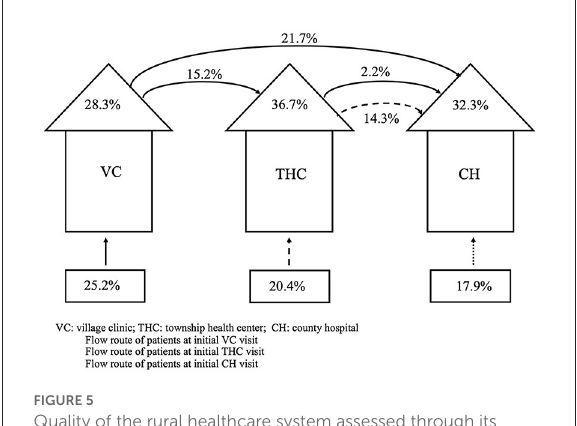
FIGURE5 Quality of the rural healthcare system assessed through its ability to correctly treat type 2 diabetes. Source: Author’s survey. VC, Village Clinic; THC, Township Health Center; CH, County